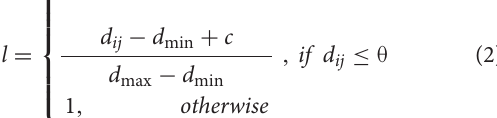
TABLE 1 | The performance of WDM-tSNE on the multiple datasets of strawberry. Balanced dataset Unbalanced dataset with more healthy leaves